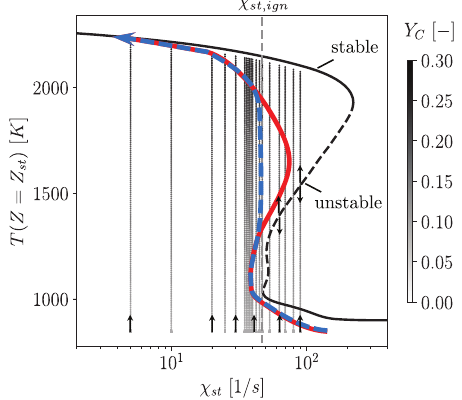
Fig. 2. Excerpt of the FLUT obtained from unsteady fl amelet solutions (dots, colored by their respective Y C value) under stoichiometric conditions. The boundary conditions are given in Table 1. Solid black lines are built by stable steady fl amelet solutions and the dashed black line denotes unstable steady solutions. Black arrows indicate the direction of evolution of the unsteady solutions depending on their initial condition. The value of v until which high-temperature ignition is possible is st marked by a vertical gray dashed line and denoted by v Possible T (cid:3) v trajectories for the original UFPV approach are st indicated by a red solid line while the corresponding trajectory for the RUFPV approach following equation (25) is shown by a blue dashed